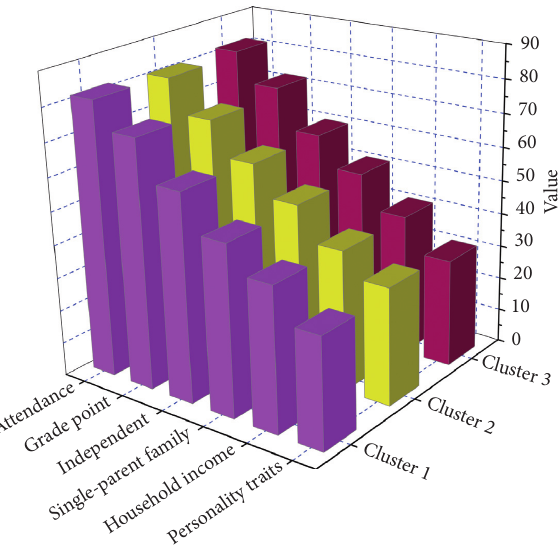
Figure 6: The final cluster centers.